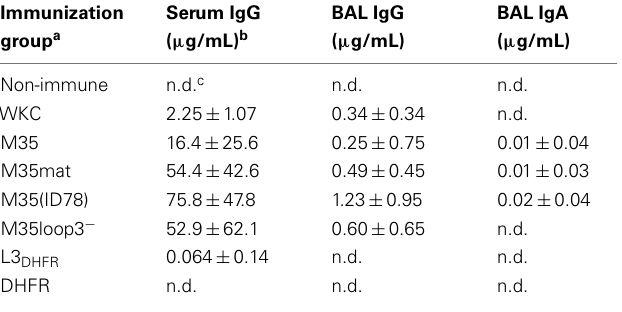
Table 1 | Specific antibody levels in serum and BAL after mucosal immunization.